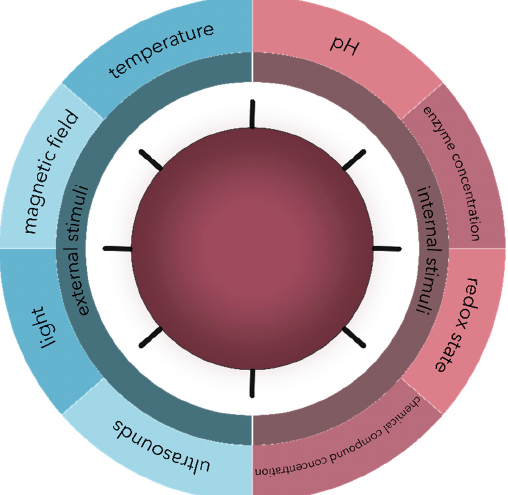
Figure 3. The main types of external and internal stimuli are involved in the controlled release of drug delivery nanosystems.